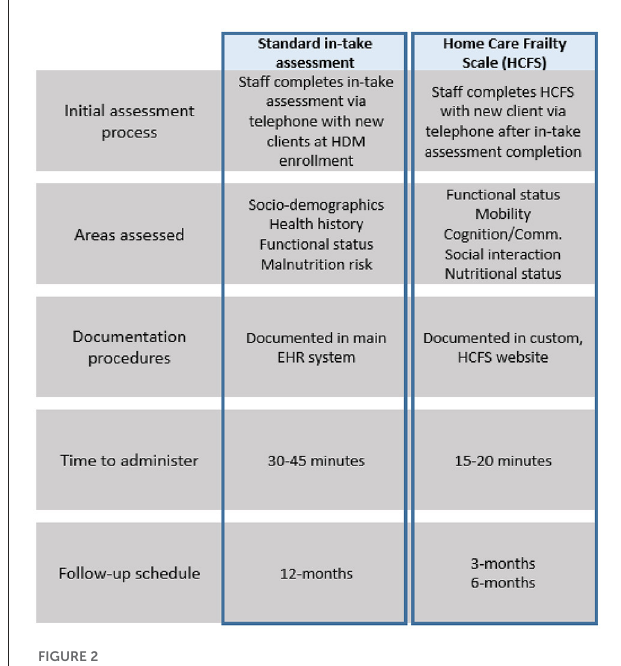
FIGURE2 Comparison of standard in-take assessment with HCFS at baseline, 3-month, and 6-months; HDM, home-delivered meals; EHR, electronic health